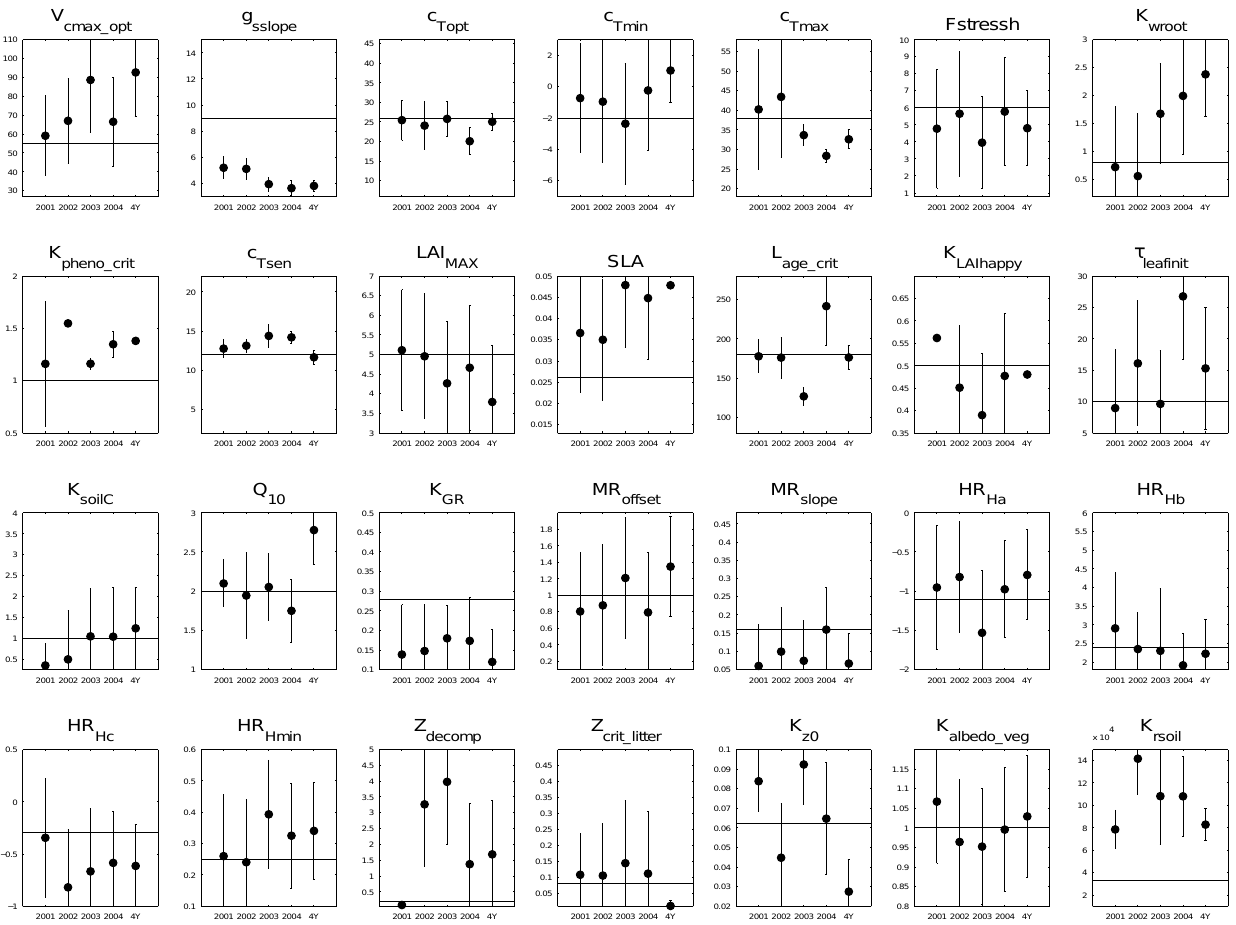
Figure 7. Optimized parameter values (circles) and errors (vertical bars) estimated by the data assimilation system in every time period (2001, 2002, ..., 4 Y for 2001–2004). Box heights specify the ranges within parameters are allowed to vary during the optimization process. Horizontal lines are the a priori values of the